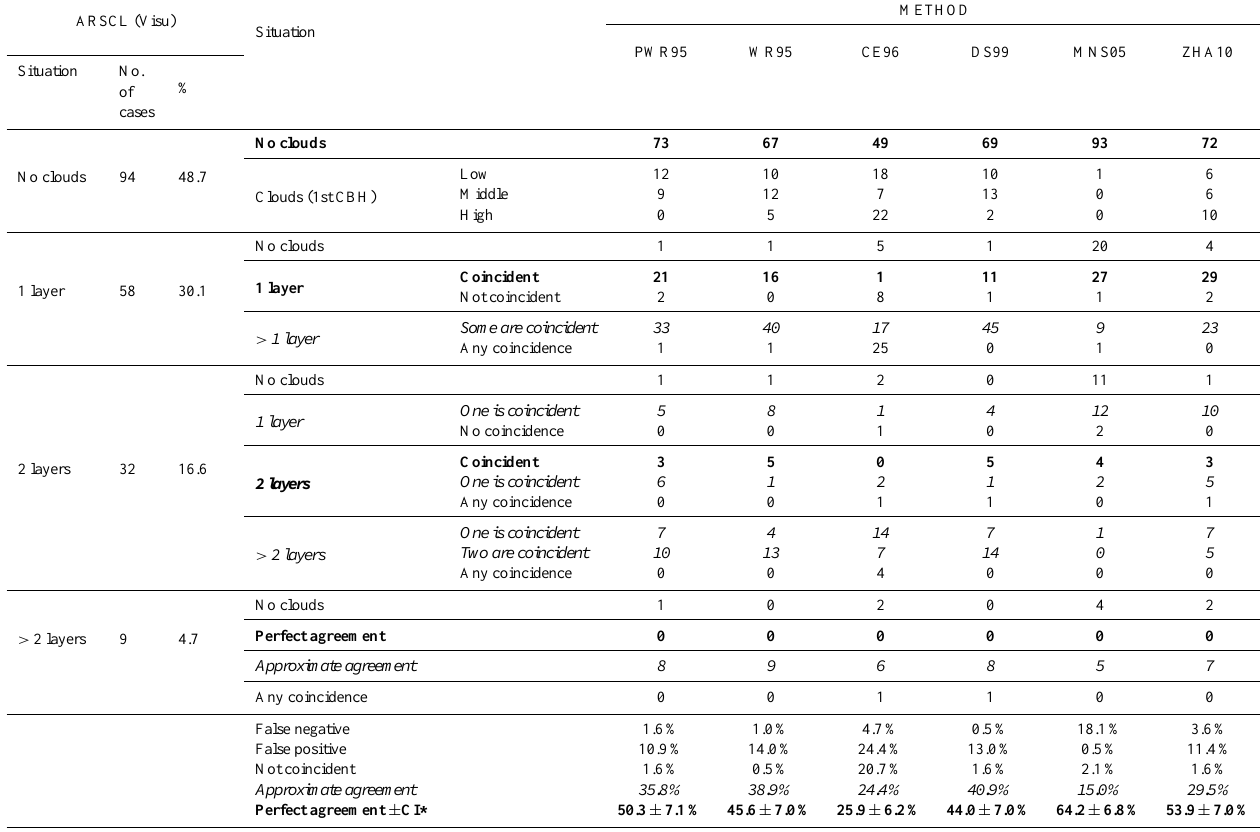
Table 4. Behavior of the six RS methods for cloud detection compared to ARSCL observations. Data in bold account for “Perfect agreement” cases; data in italics account for “Approximate agreement” cases.